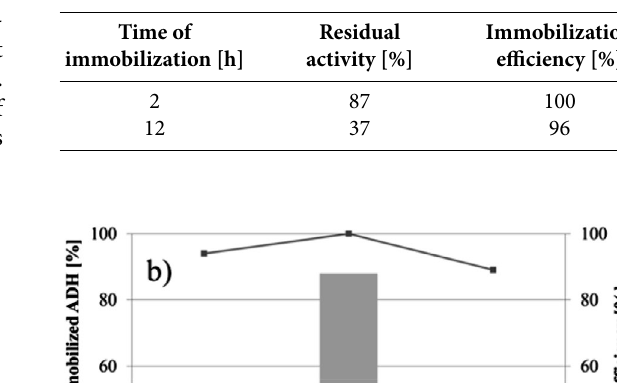
Table 1 . Residual activities and immobilization efficiency of ADH immobilized onto epoxy functionalized CMD-MNPs, while investi- gating time of